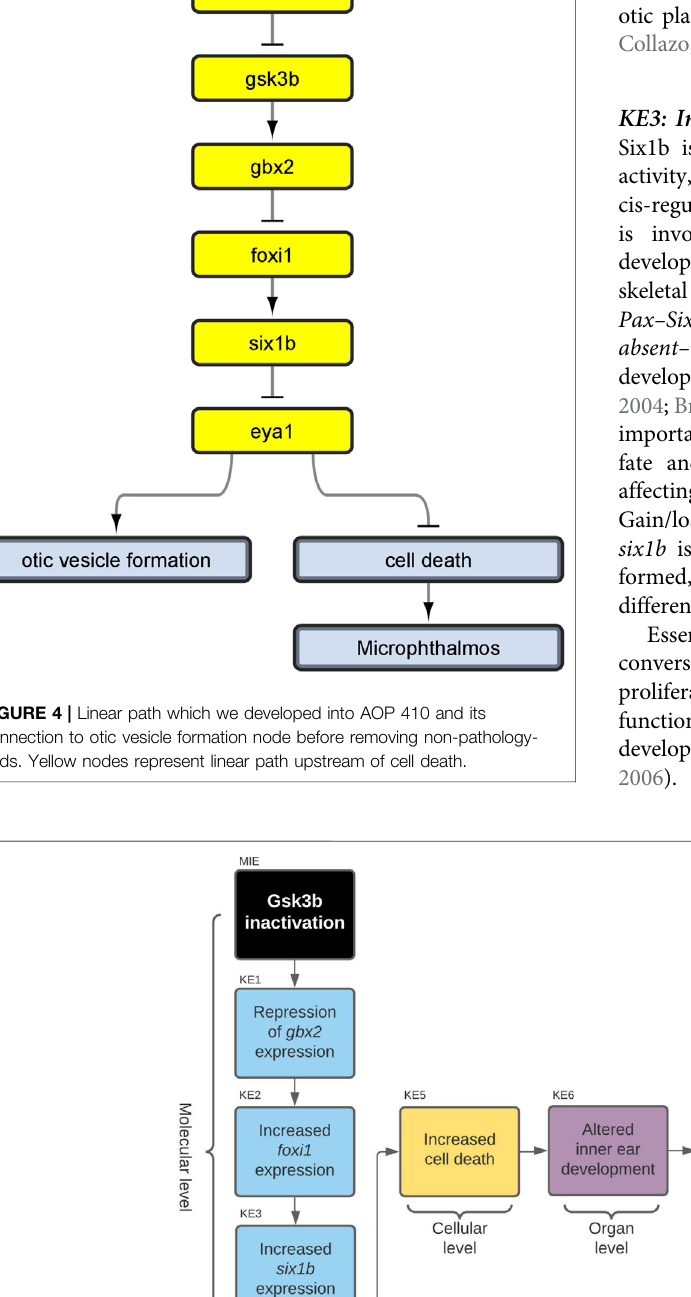
Frontiers in Toxicology |